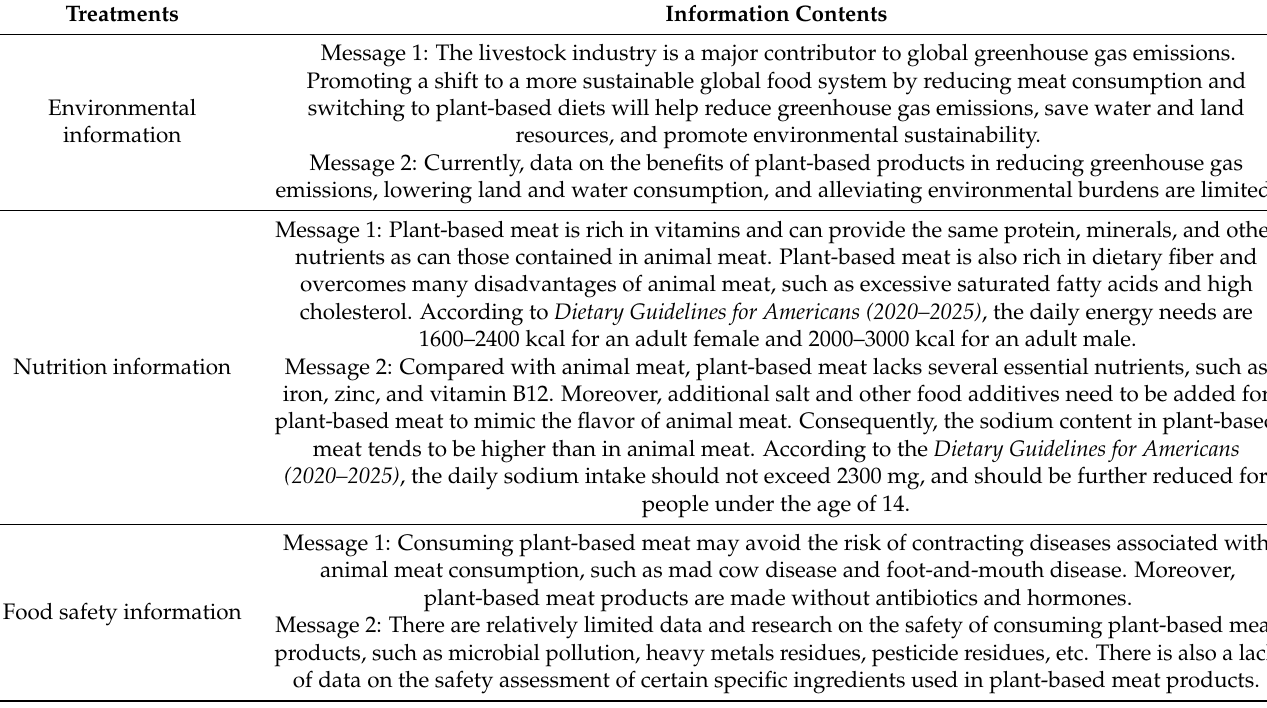
Figure 1. Example of a choice set. Table 1. Contents of information